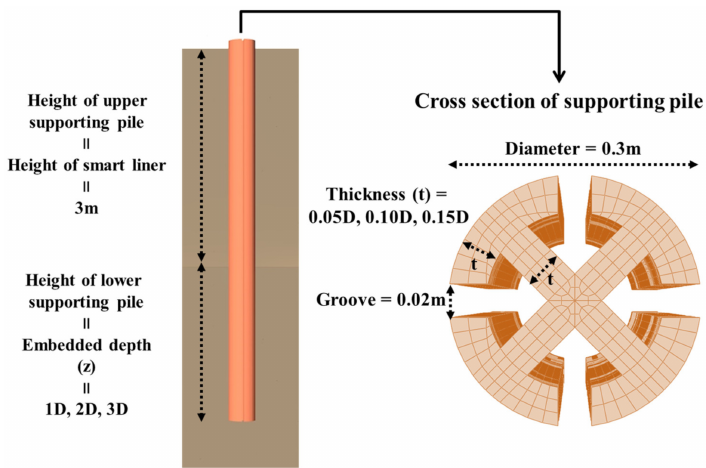
Figure 15. Analysis parameters of RSIM. Table 2. Analysis cases of RSIM.